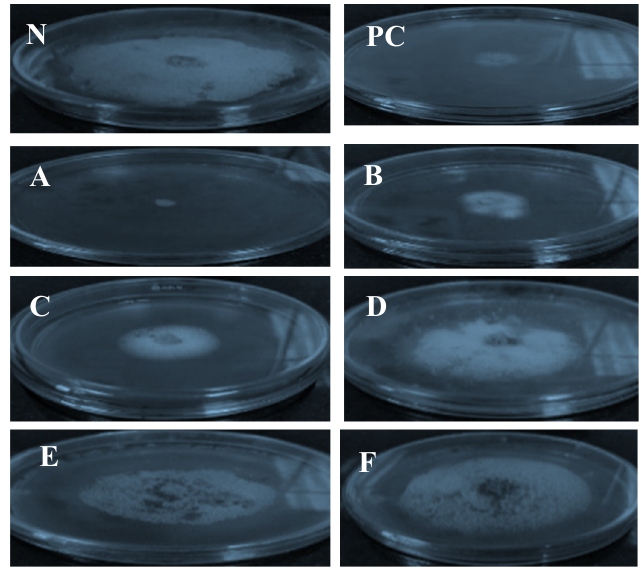
Figure 3. Effects of T. vulgaris oil ( A ), chloroform ( B ), dichloromethane ( C ), ethanol ( D ) and ethyl acetate extracts ( E ) of O. europaea leaves and B. carteri ( F ) on mycelium linear growth of. F. oxysporum f. sp. lactucae after six days of cultivating the fungus on PDA medium at 25 ◦ C. NC: negative control (DMSO), PC: positive control (Nystatin).